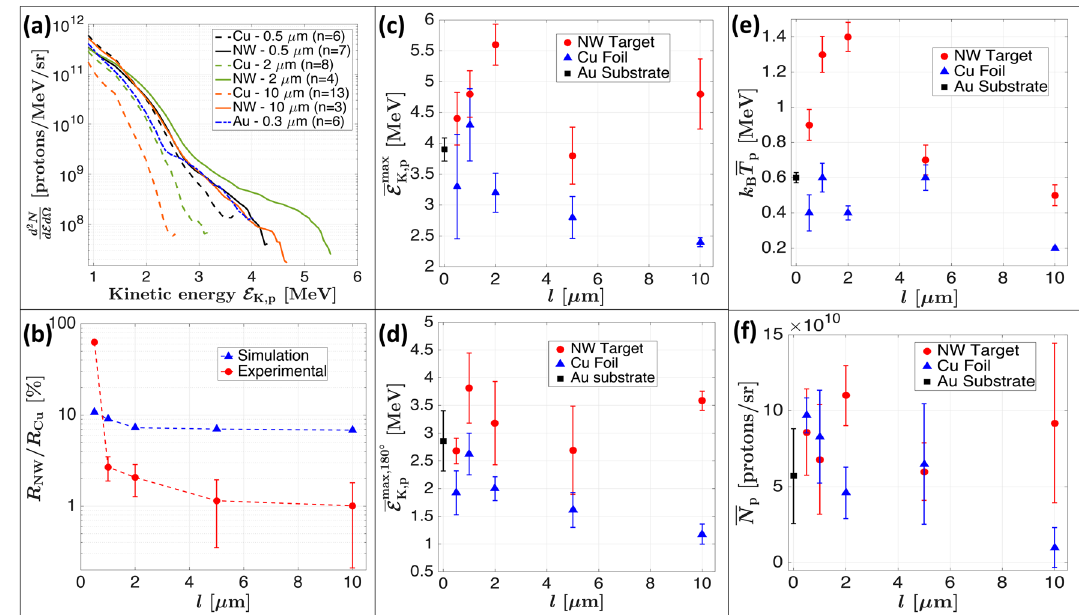
Figure 3. Experimental results for NW length investigation. ( a ) Averaged spectra for NW targets (solid lines) along with their thickness-equivalent Cu reference foils and the bare Au substrate of 0.3 µ m (dotted lines). ( b ) Reflectivity ratios of NW targets and Cu foils as obtained experimentally from the Spectralon diffuser (red points) and through PIC simulations (blue diamonds). Proton spectra characteristics ( c – f ) shown for NW targets (red circles), Cu reference foils (blue diamonds) and the bare 300 m-thick Au substrate (black squares). max ( c ) Average maximum proton energy in the forward acceleration direction E K,p . ( d ) Average maximum proton max,180 ◦ k B T p as obtained by energy in the backward acceleration direction E K,p . ( e ) Average proton temperature a linear fit on the log-plotted spectra in the high energy section. ( f ) Average integrated proton numbers N p 0.5 , 1, 2, 5 and for E K,p > 1 MeV. The cumulated number of shots are of 7, 7, 4, 4 and 3 for NWs of length l = 10 µ m respectively. For Cu foils, the cumulated number of shots are of 6, 18, 8, 10 and 13 for thicknesses of 0.5, 1, 2, 5 and 10 µ m respectively, as well as 6 shots the Au substrate. The shown uncertainties are the total standard deviations (instrument accuracy and shot-to-shot fluctuation summed in